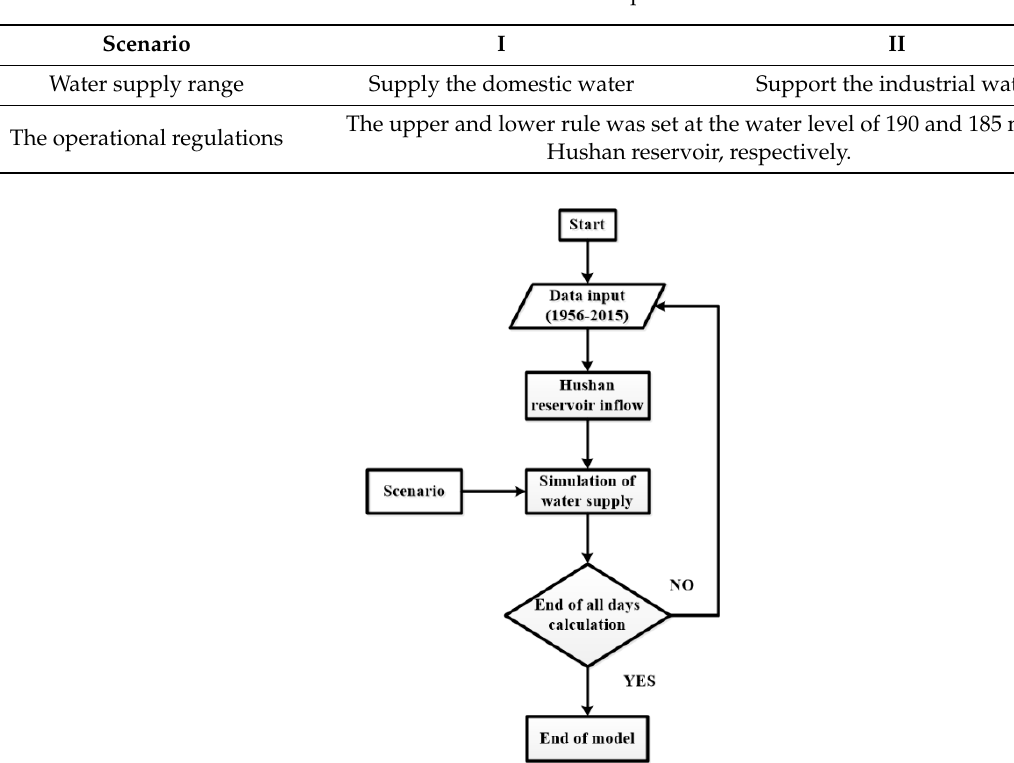
Table 2. Scenario description.